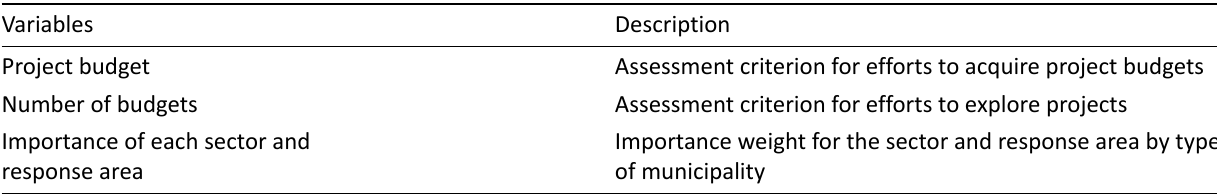
Table 2. Selection of variables for assessing the level of the heat wave adaptation policies.